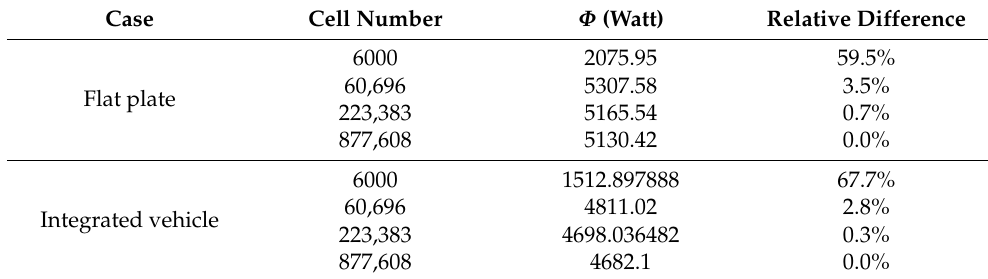
Table 4. Mesh sensitive study for turbulent